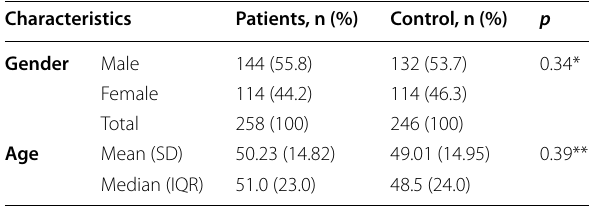
Table 2 Demographic characteristics of COVID-19 patients and control